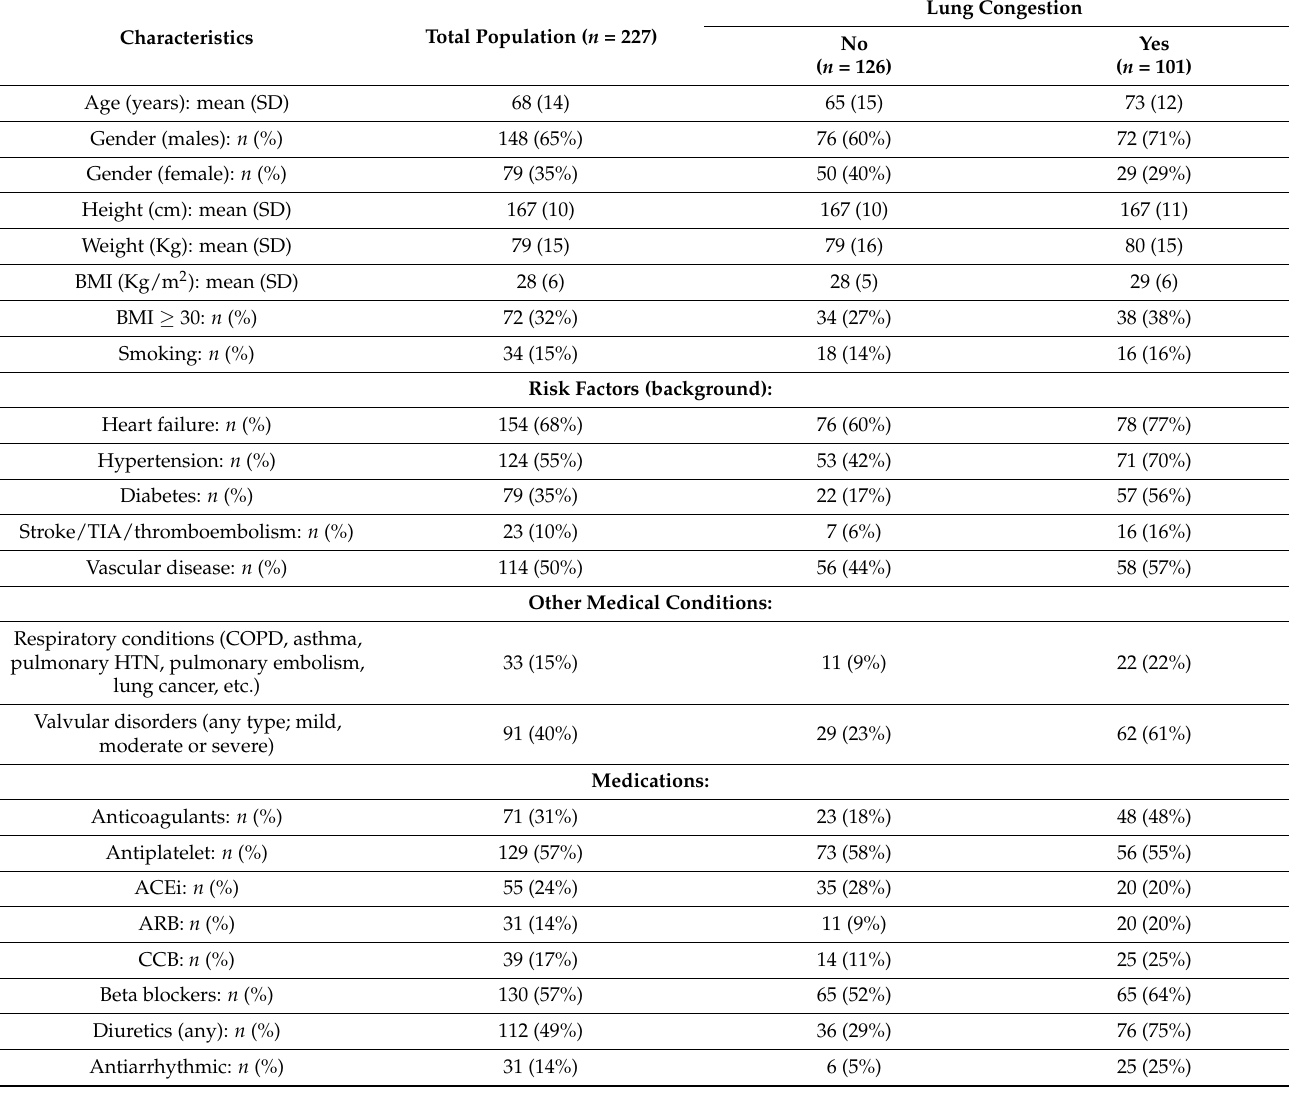
Table 1. Baseline characteristics of study population.